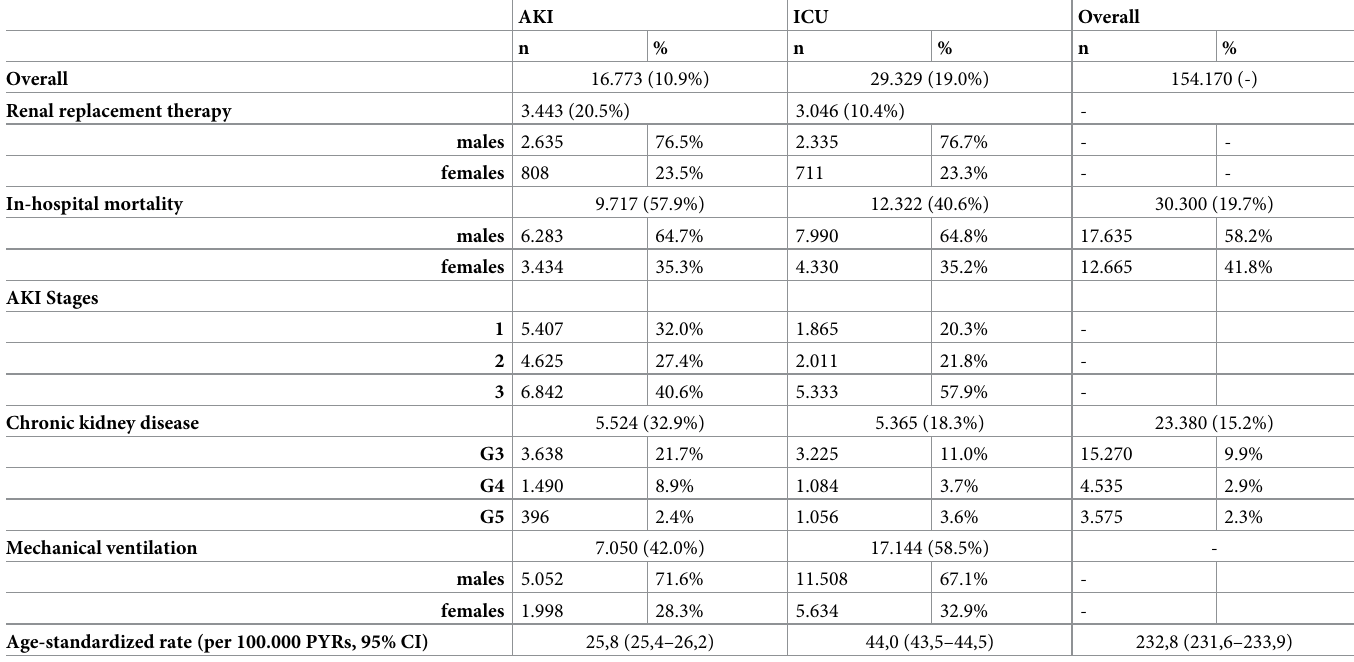
Table 2. Results COVID-19 hospitalizations in Germany 2020.